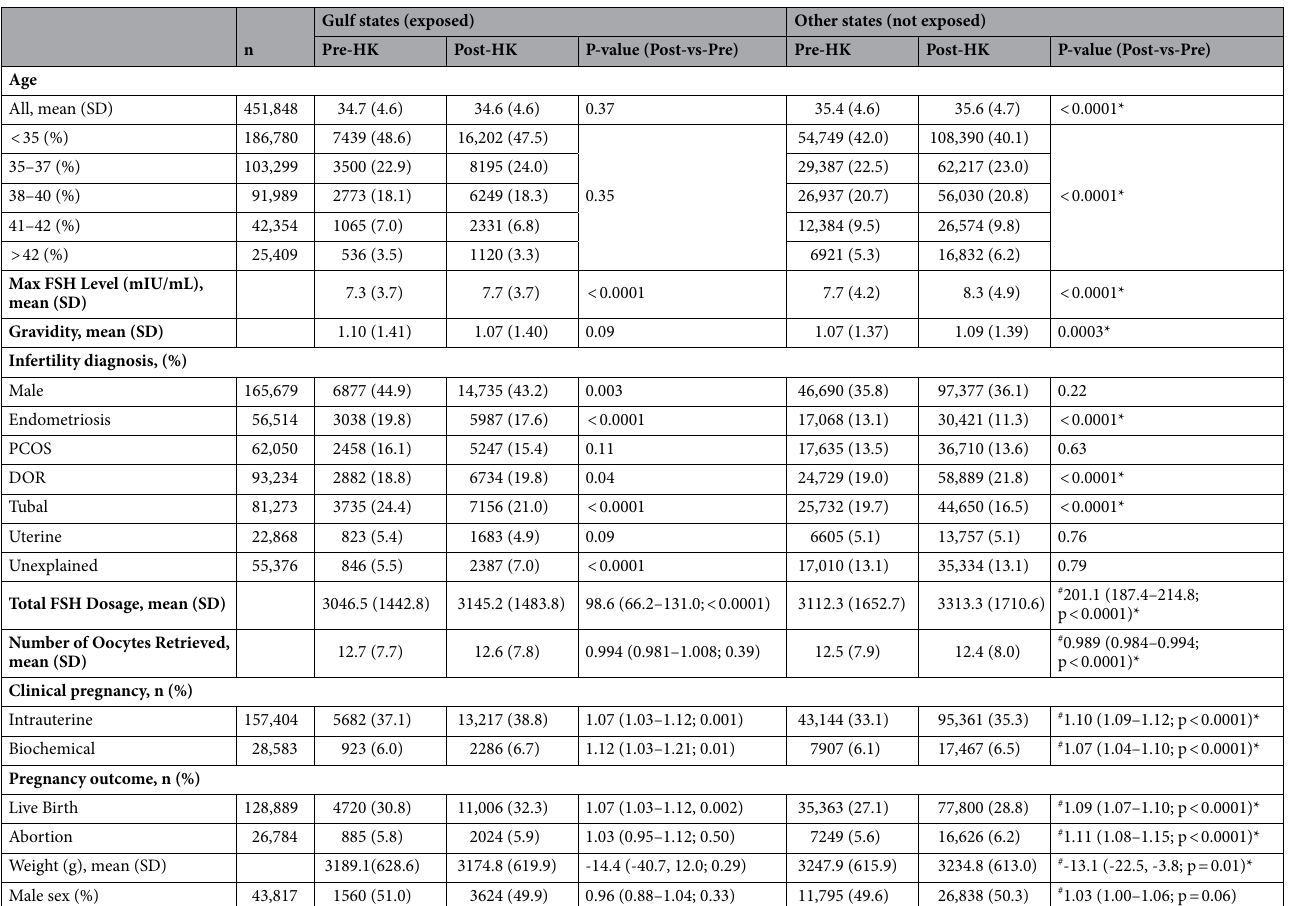
Table 1. Univariate analysis of outcomes grouped by exposed (gulf states) and unexposed (all other states) and then further subdivided by time period, pre and post HK. *Significant p-value. # Odds ratios with 95% CIs were given for the outcome variables (total FSH dosage, number of oocytes retrieved, clinical pregnancy, pregnancy outcome, weight, and male sex) in addition to the